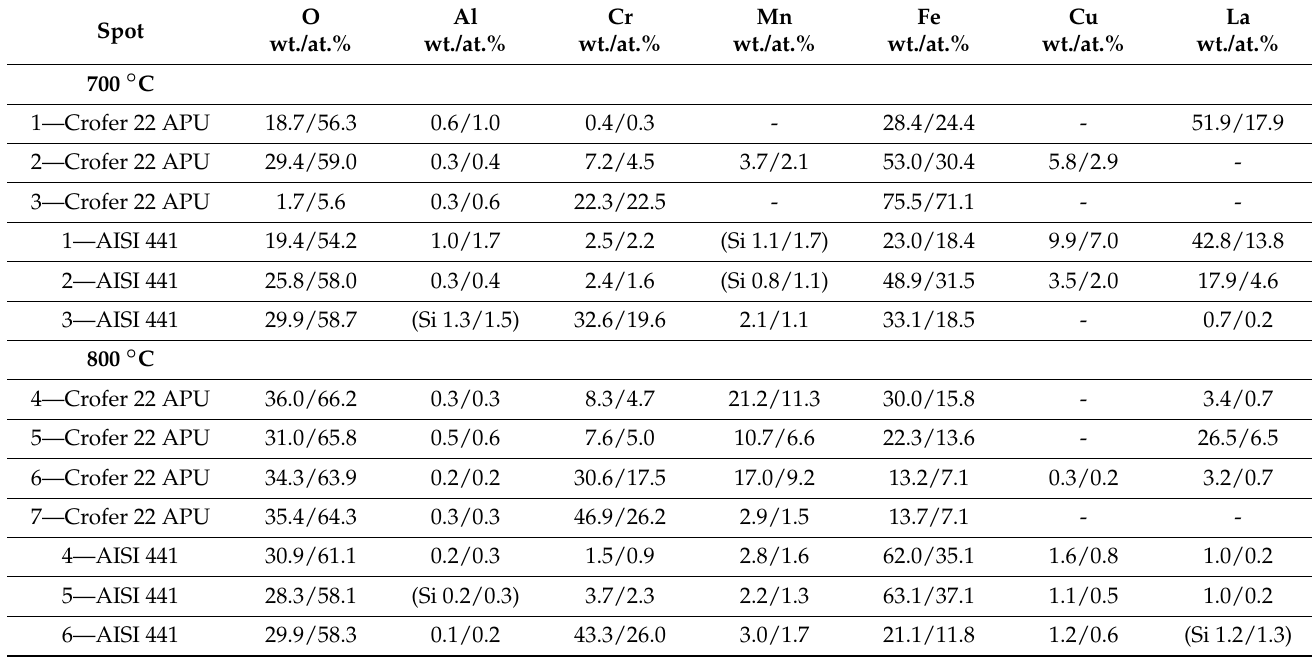
Table 6. Element concentrations in wt./at.% measured with EDS analysis from LFO coated Crofer 22 APU and AISI 441 after 1500 h at 700 ◦ C and 800 ◦ C. The location of the spots is marked in Figure 10.